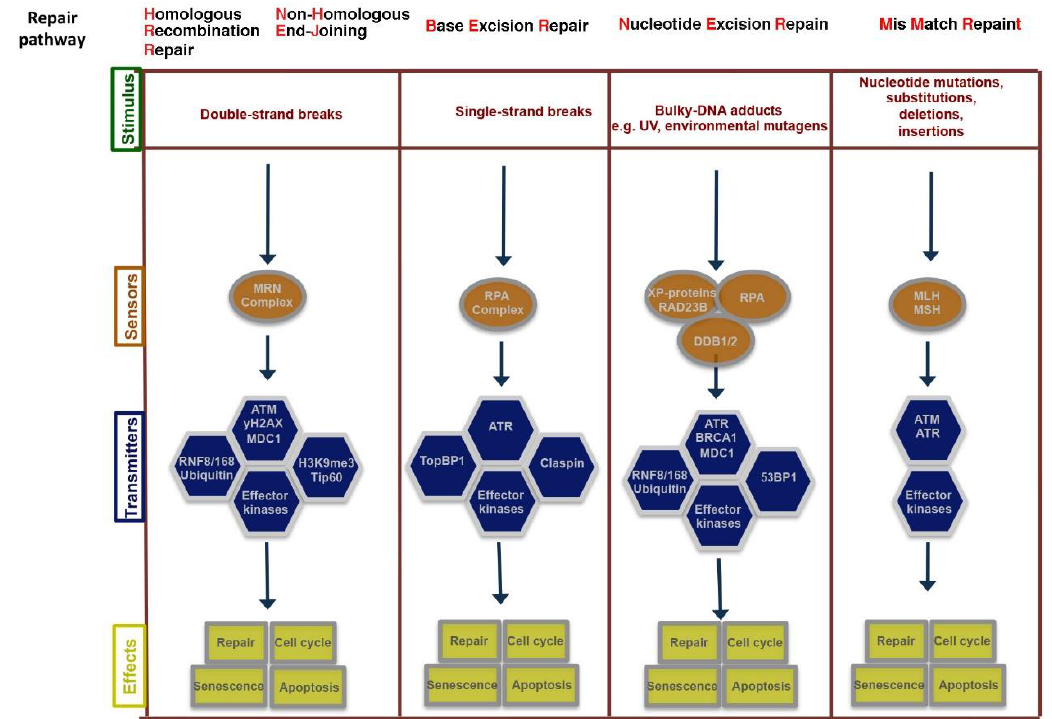
Figure 2. Schematic representation of the sensors, transducers and mediators involved in DNA damage response (DDR) pathways. DNA damage response is sensed and repaired by multi-protein complexes. Depending on the level of injury, the signaling triggered by the damage response will 119 result in different cellular fates. 120